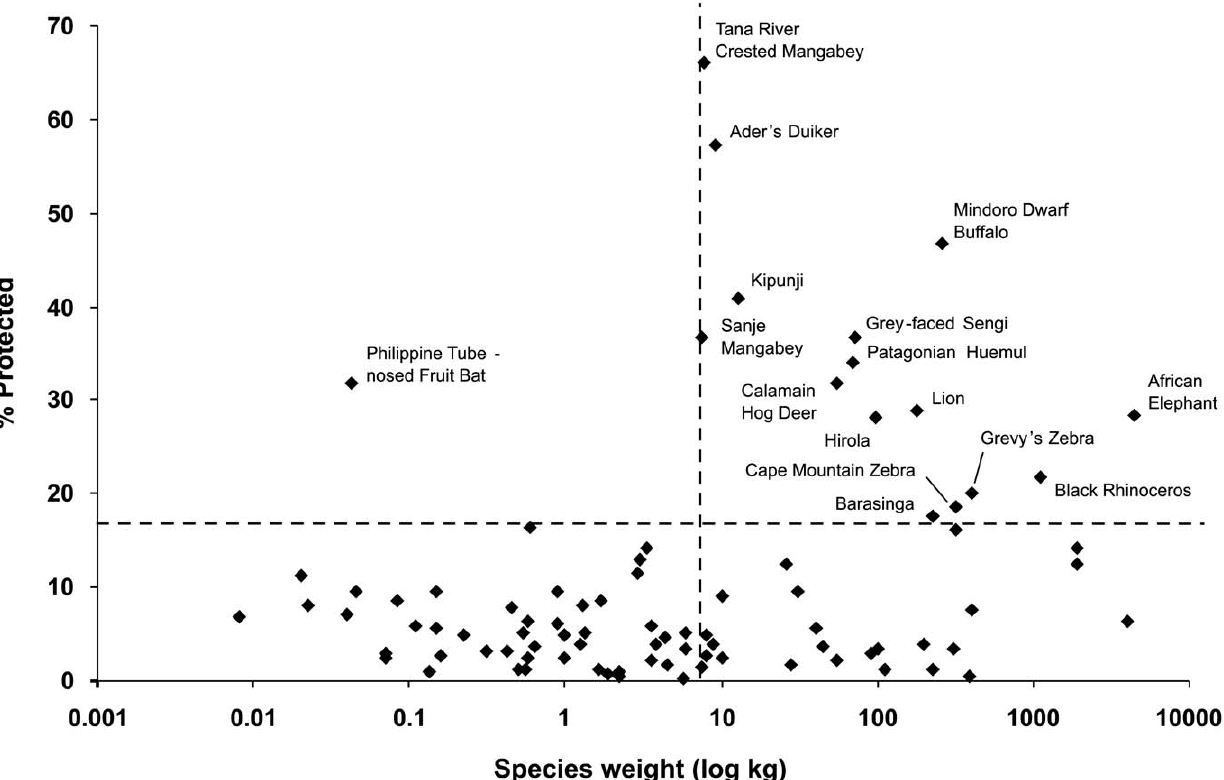
Figure 3. Proportions of populations dependent on tourism (T), relative to body weight. Dotted lines indicate 7.5 kg mean body weight, and 17% protected.